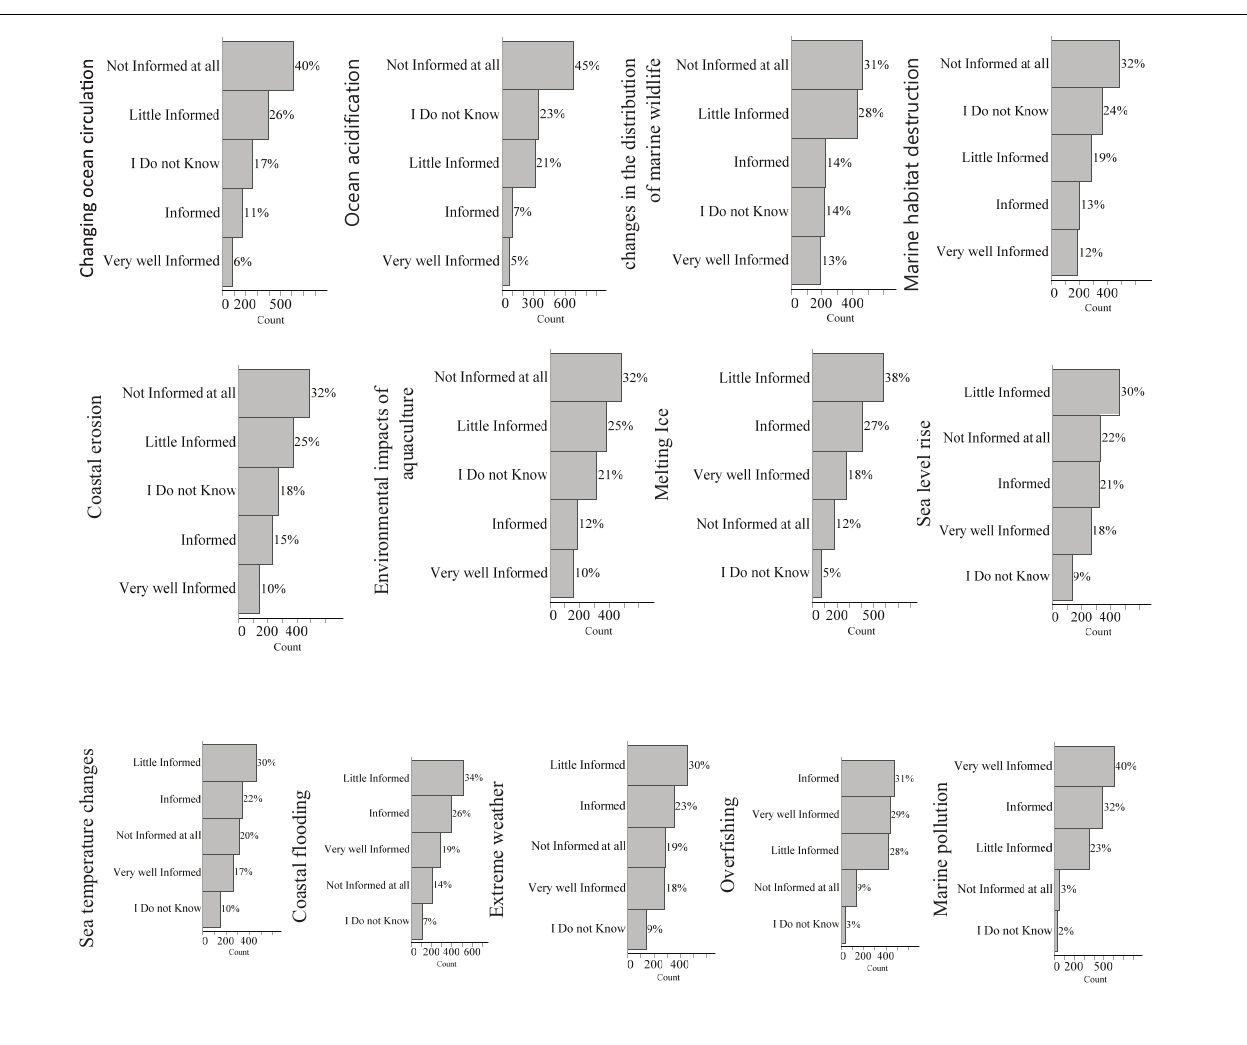
Frontiers in Marine Science |